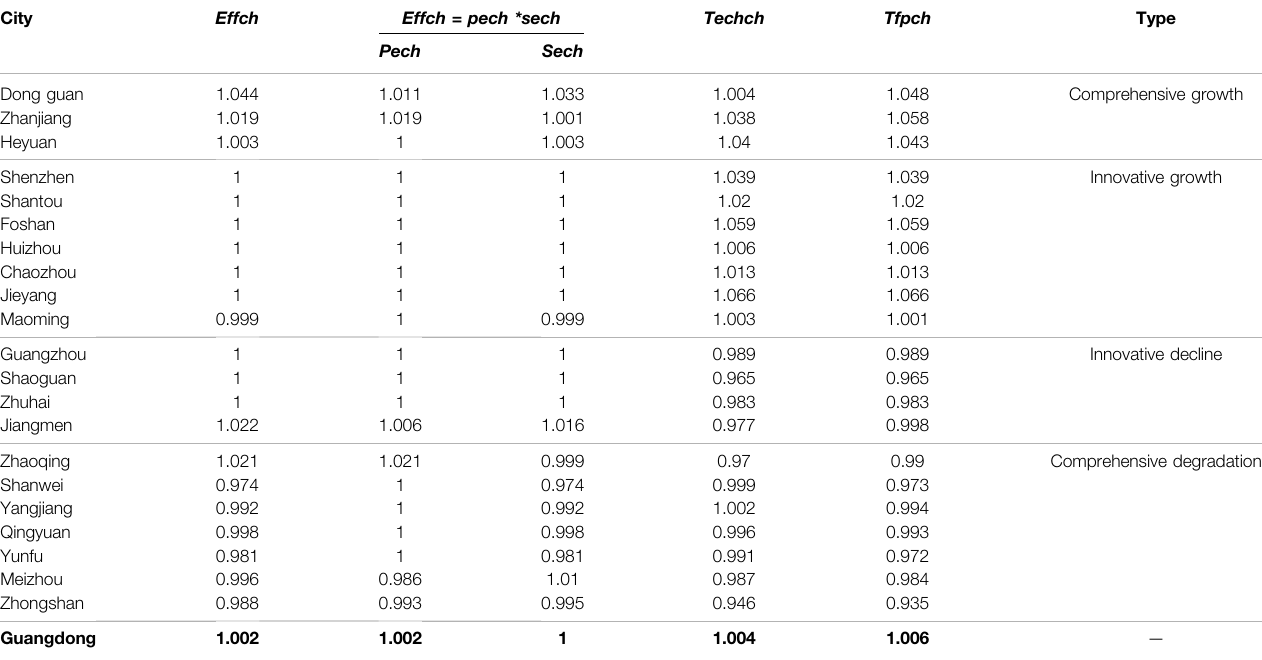
TABLE 7 | Average Malmquist index and its decomposition value of cities in Guangdong Province in 2019 – 2025. City